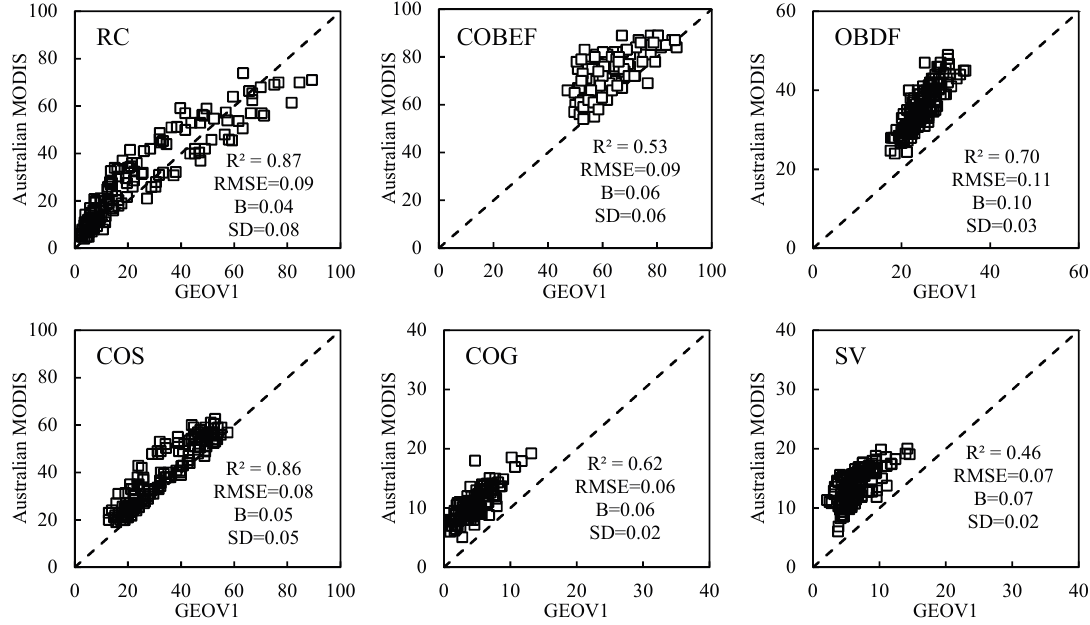
Figure 3. Scatterplots of the two products over the main biome types in Australia for the 2000–2012 period. The terms B and SD represent the bias and the standard deviation of the differences between the FVC